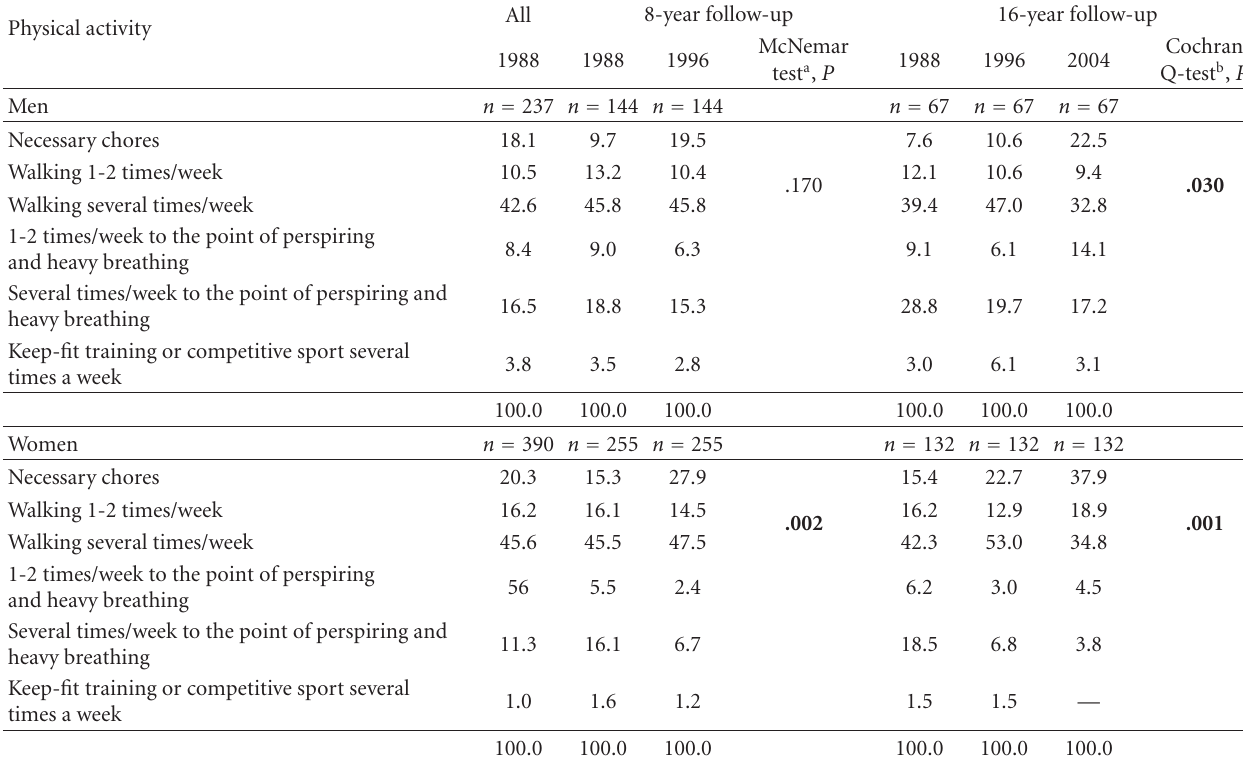
Table 1: Physical activity (frequency and intensity) among men and women aged 64–74 years at baseline and in 8- and 16-year follow-up studies, (%, P